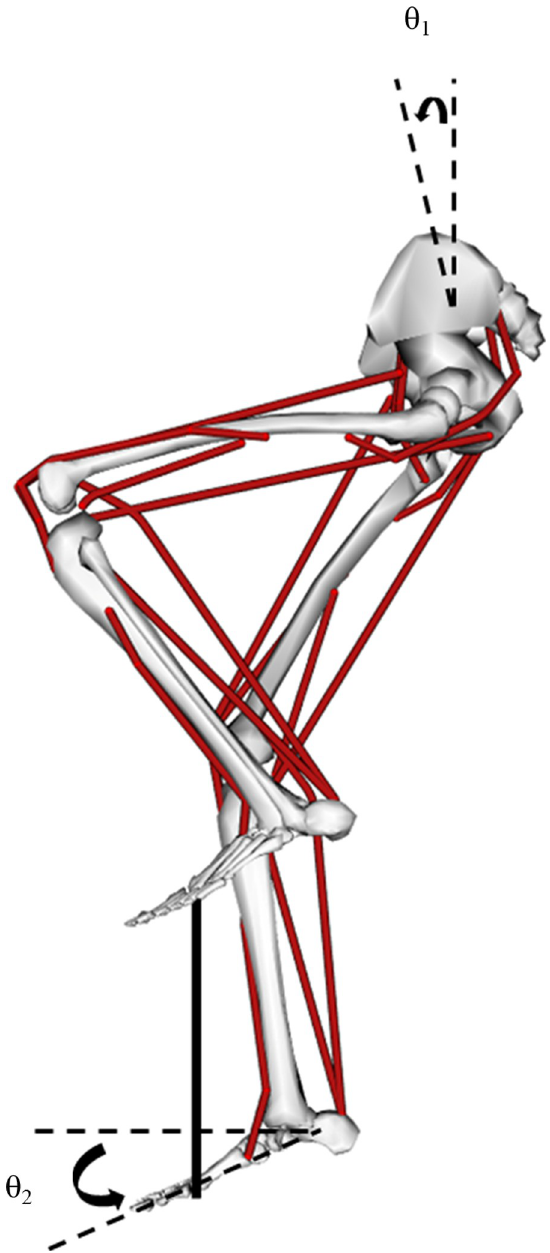
Fig 1. The bicycle-rider model in OpenSim. The developed 2-D bicycle-rider model consists of eight rigid segments (bicycle crank, pelvis, paired thighs, lower legs, and feet) and nine muscle tendon unit per leg (iliopsoas, gluteus maximus, vasti, rectus femoris, hamstrings, biceps femoris short head, gastrocnemius, soleus, and tibialis anterior). Pelvic tilt angle ( θ 1 ) was set to 11.5˚ and pedal angle ( θ 2 ) was determined by angular deviation between the horizontal and line connecting from the toe to the